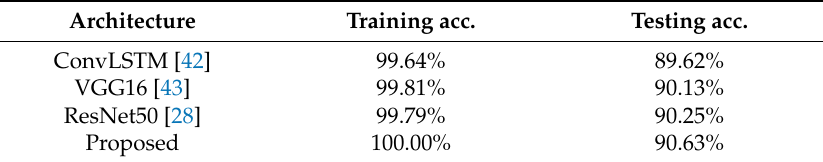
Table 5. Accuracy (acc.) of our rehabilitation action dataset.